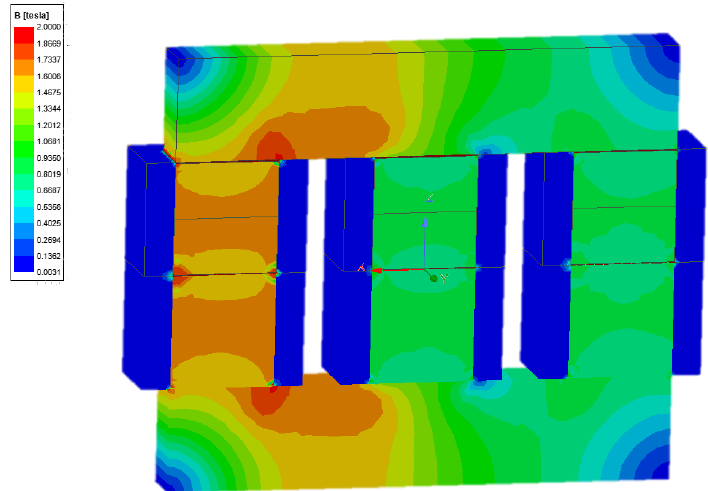
Figure 11. Magnetic-flux-density distribution in the choke designed for Case “B”. Figure 12.